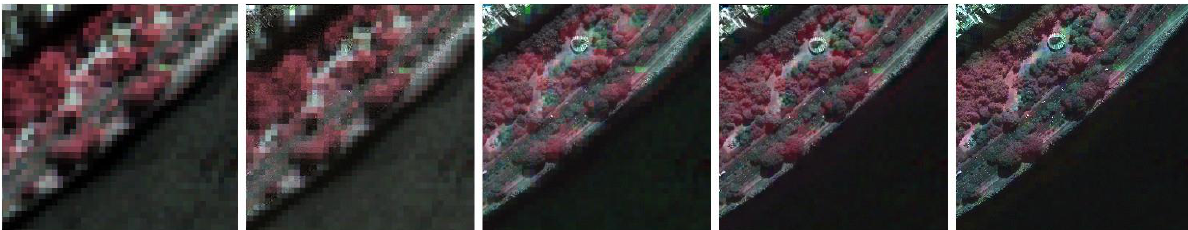
Figure 4. Results of the fusion experiment on an area of building. From left to right: Original SWIR images; ATWT; HIS; PCA and the proposed method.